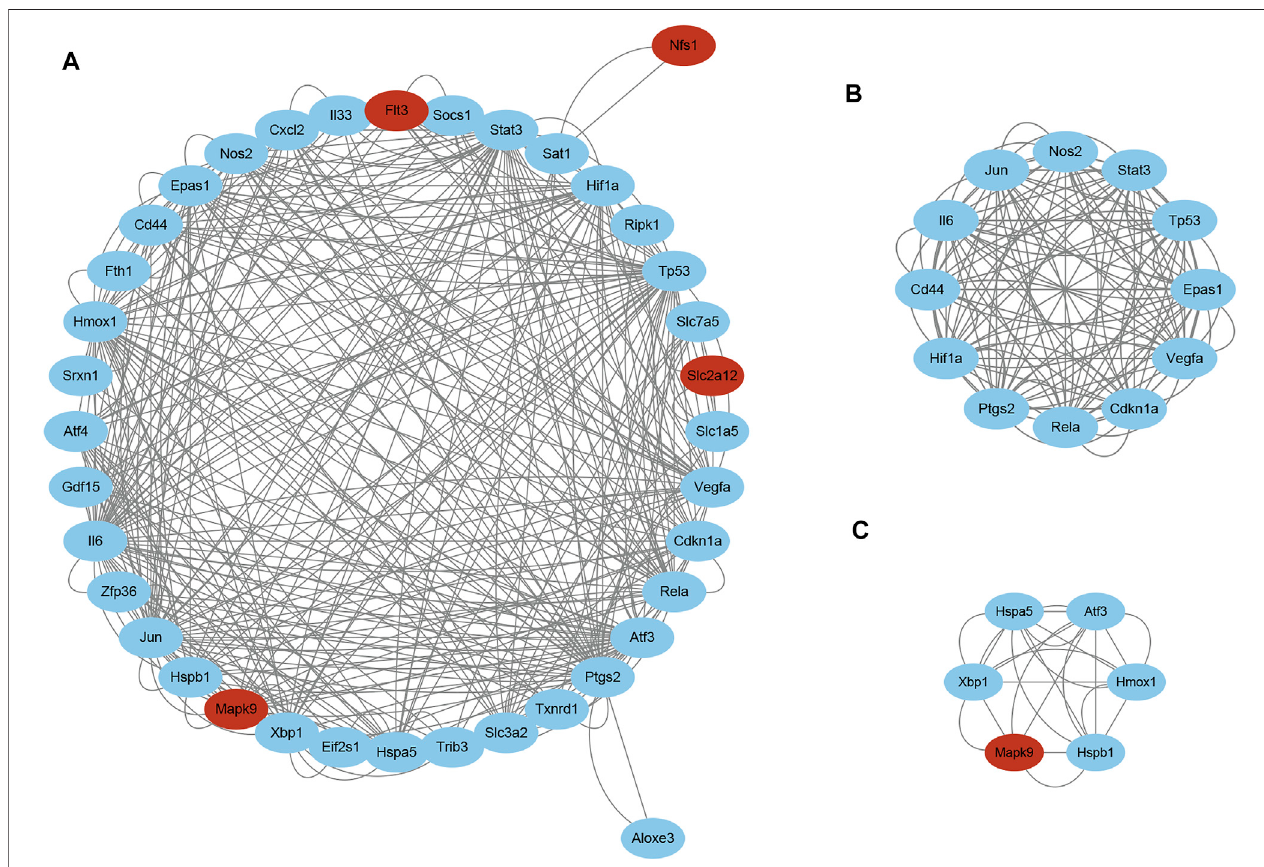
FIGURE 5 | PPI network analyses of ferroptosis DEGs. (A) PPI network of ferroptosis DEGs visualized using Cytoscape. Red and blue nodes represent downregulated and upregulated genes, respectively. Two key modules identi fi ed using MCODE, (B) Cluster 1 and (C) Cluster 2. Abbreviations: DEGs, differentially expressed